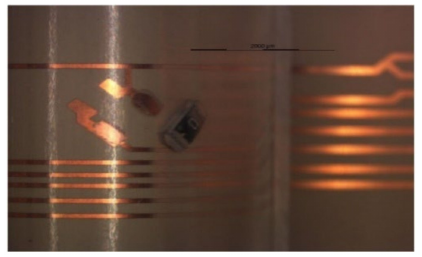
Figure 23. An out-of-place component at 2000 µ m.